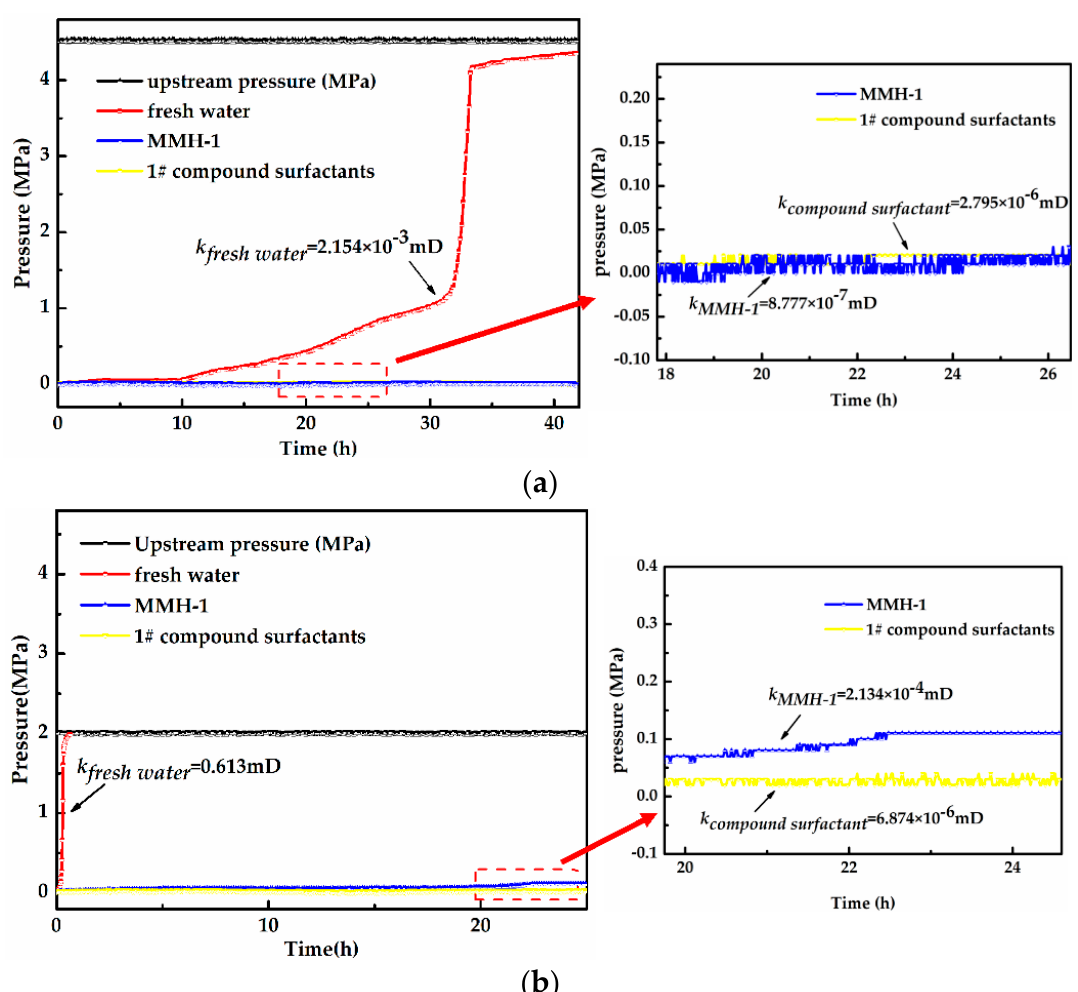
Figure 8. Effect of MMH-1 and 1# compound surfactants (0.001 wt% CS-4 + 0.001 wt% CS-1 + 0.001 wt% CS-3) on retarding pressure transmission of shale and coal. ( a ) Shale sample pressure curve versus time; ( b ) Coal sample pressure curve versus time.